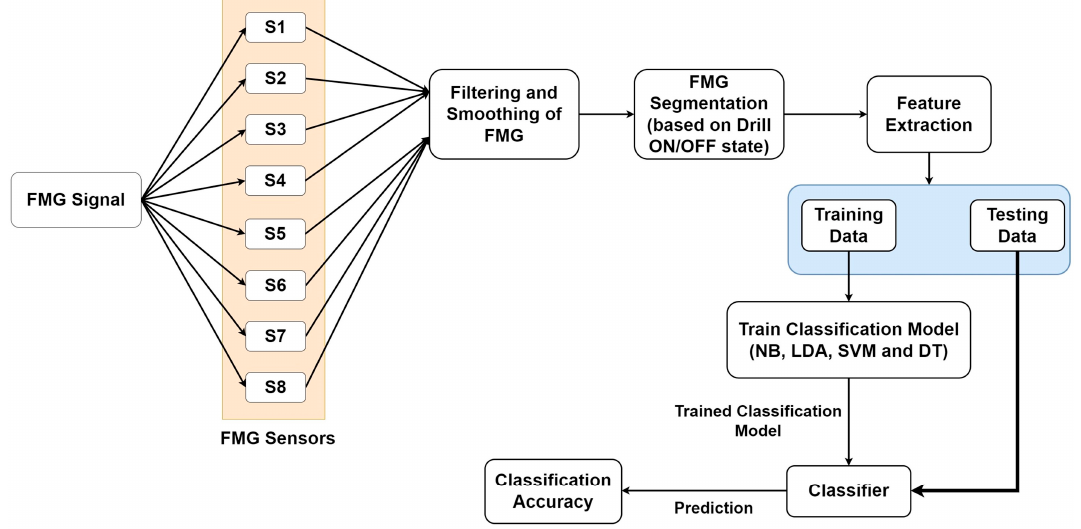
Figure 4. Methodology for the analysis of force myography data (FMG) data for skills evaluation.